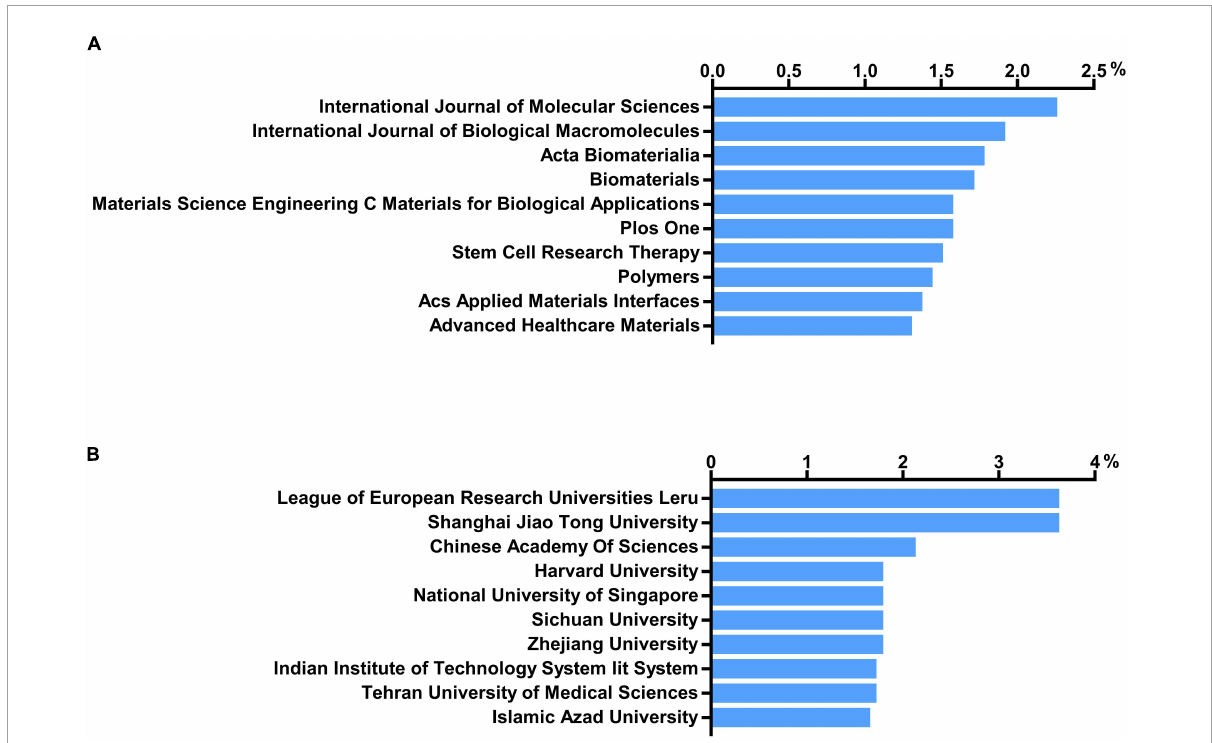
FIGURE3 Number of institutions and journals focusing on skin regeneration. (A) Top 10 journals publishing research on skin regeneration; (B) top 10 institutes publishing research on skin regeneration.